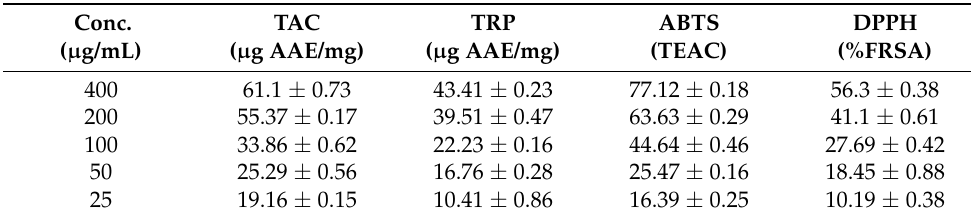
Table 2. Antioxidants potentialities of biosynthesized MgO-NPs. Conc.